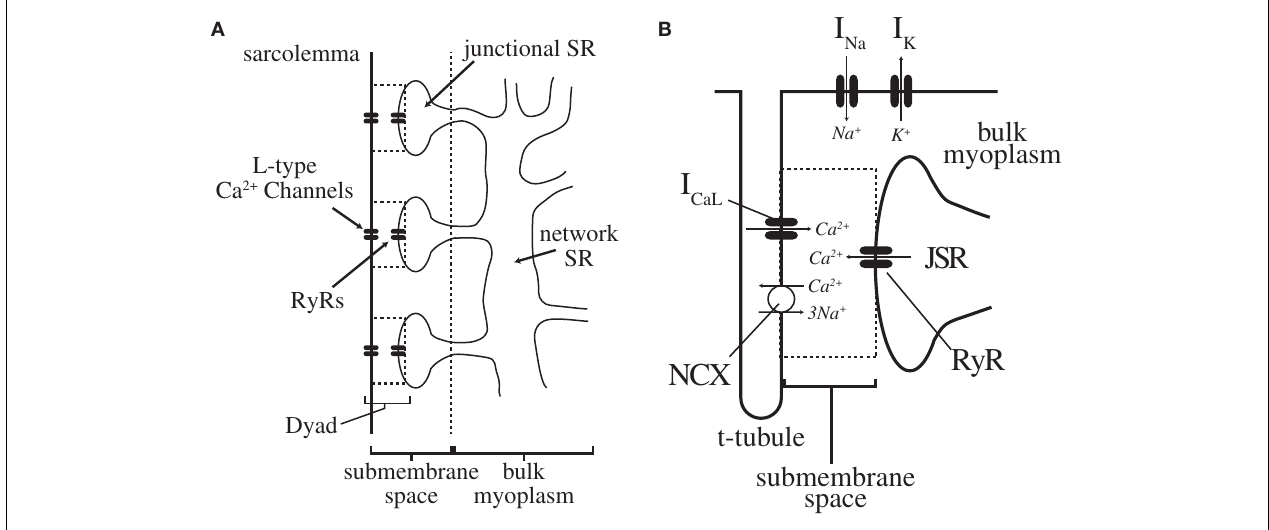
and Orchard, 2003) for more detail). (B) Each dyadic junction itself consists of the close apposition of a junctional branch of the SR with the sarcolemma, and contains the L-type Ca 2 + channels and RyRs (in the sarcolemma and SR, respectively) necessary for CICR. A single myocyte contains on the order of 10 4 of these dyads arranged in a regular array, and the global Ca 2 + transient is the summation of several thousand individual release events (Ca 2 + -sparks) occurring at these sites. For a more complete description of specific ionic currents, see Shiferaw and Karma (2006), from which this figure was